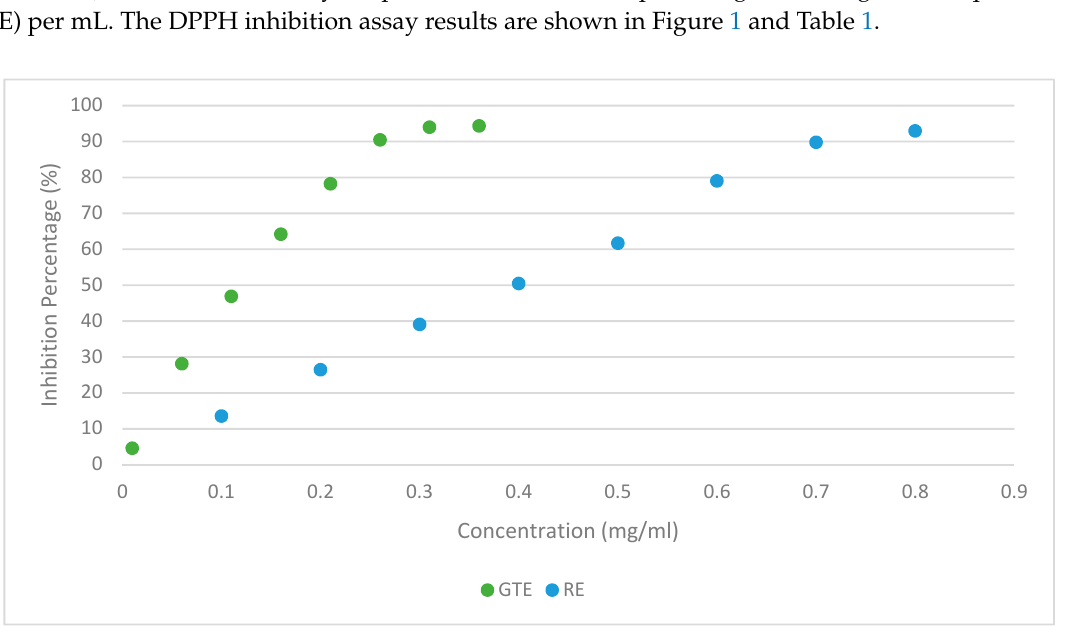
Figure 1. Study of Green Tea Extract (GTE) and Rosemary Extract (RE) antioxidant capacity through the DPPH assay inhibition percentage. Table 1. Results of DPPH radical assay expressed in Inhibition Percentage (%) and µg Trolox equivalents per ml (µg TE/mL) (mean ± Standard Deviation (SD)) for Green Tea Extract (GTE) and Rosemary Extract (RE). Different letters are for significant differences ( p < 0.05).